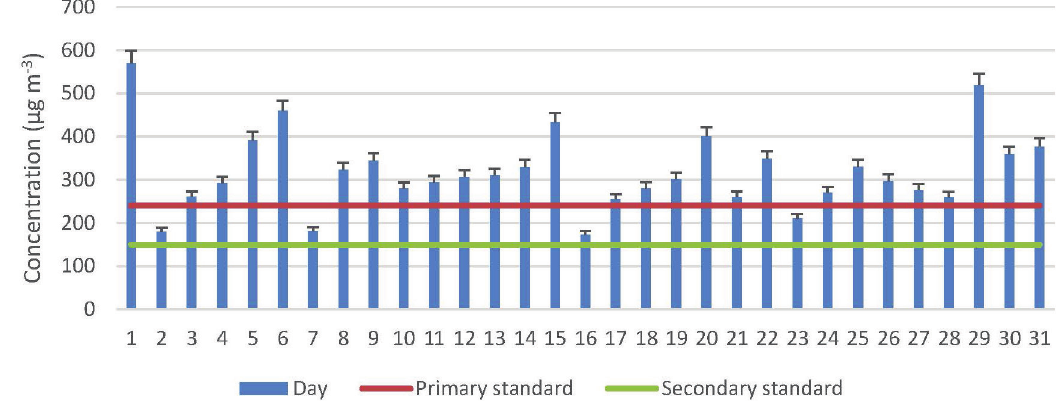
Fig. 3 – Daily concentration of particulate matter (PM